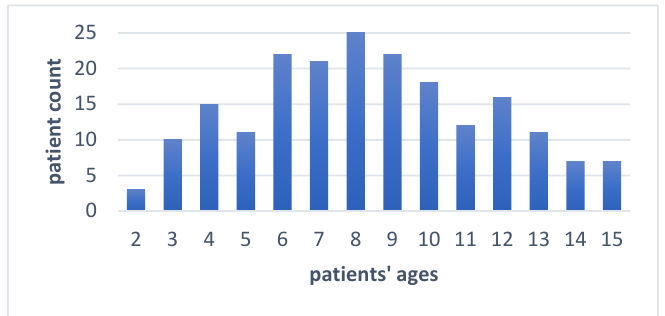
Figure 1. Graphic representation of the patients’ distribution according to their age. Oxygen saturation readings of the dental pulp and the nasal wing were performed.